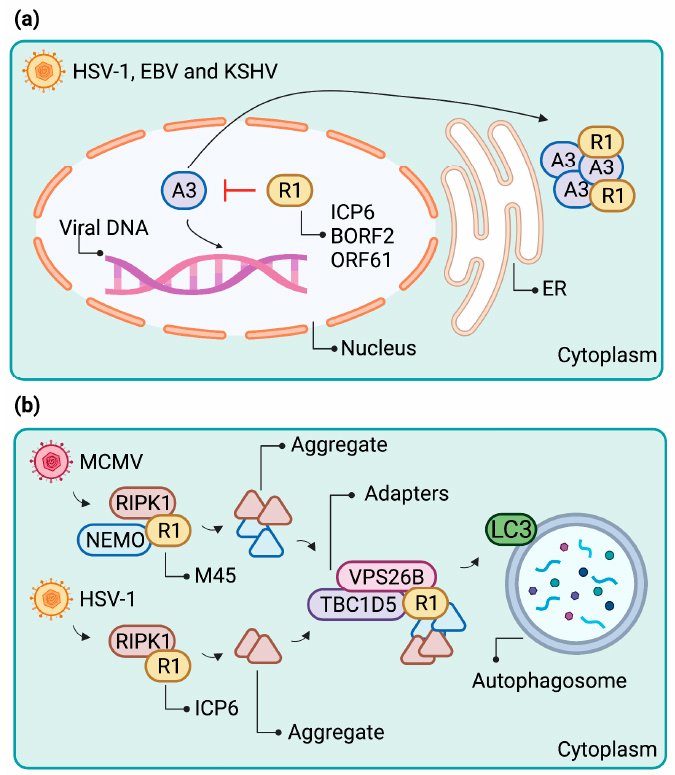
Figure 3. Schematic representation of R1s and aggregate formation. Detailed mechanism of cellular protein degradation by herpesvirus R1s. ( a ) HSV-1, EBV, and KSHV R1 target nuclear APOBECs (A3) and concentrate them to perinuclear clusters that resemble protein aggregates. ( b ) MCMV and HSV-1 R1 induce the formation of aggregates containing antiviral proteins. They then recruit autophagy adaptor proteins that facilitate the removal of aggregates through aggrephagy. Figure created with BioRender.com (accessed on 26 August